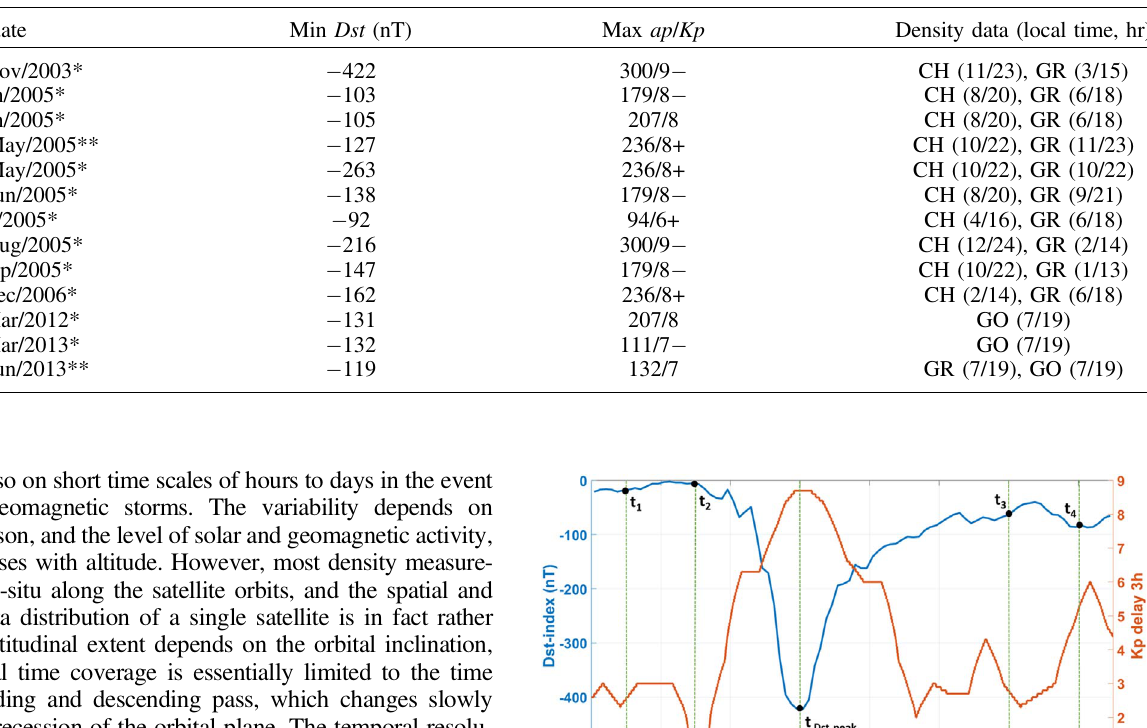
Table 3. Selected storm intervals and type (* = coronal mass ejection; ** = high speed stream), minimum Dst and maximum ap / Kp , satellite density data (CH = CHAMP, GR = GRACE, GO = GOCE) and rounded local time at equator (hr).